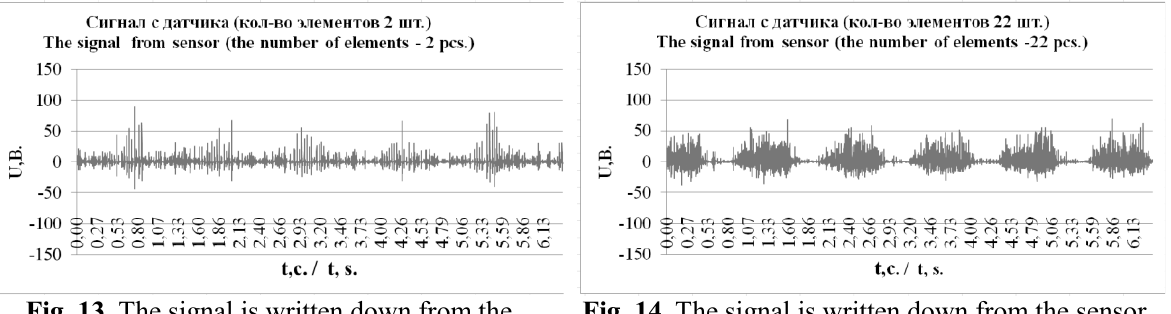
Fig. 13. The signal is written down from the sensor which contains 2 balls in the housing.